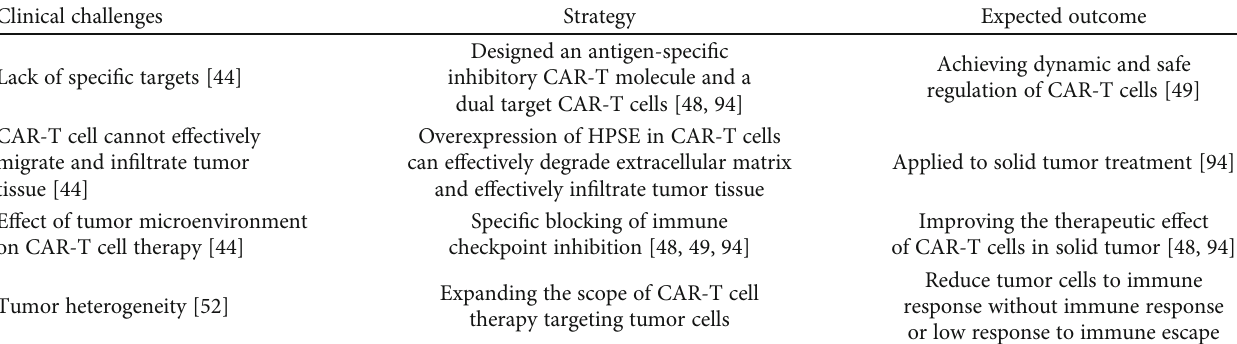
Table 1: Treatment and challenge of CAR-T cell therapy in the treatment of solid